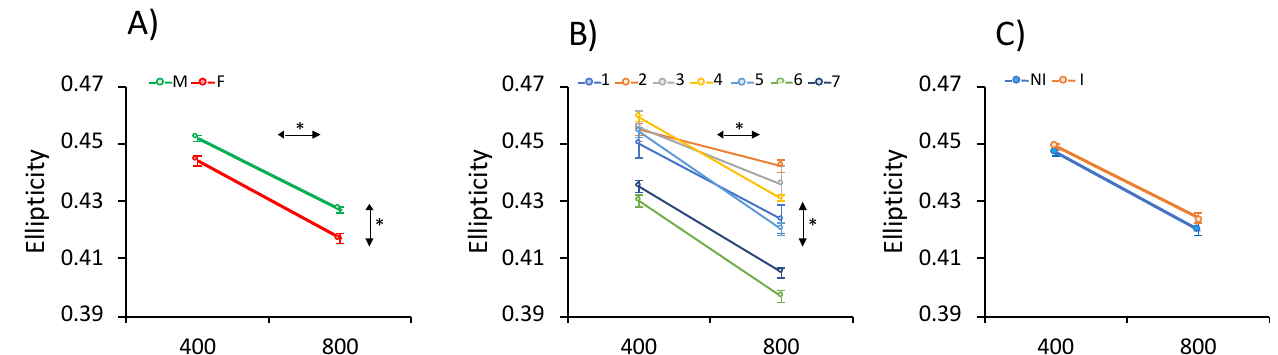
Figure 6. Estimated marginal means for ellipticity as determined by repeated-measures ANOVA at 400 and 800 days (d) for the ( A ) gender (male: M; female: F), ( B ) Evaluation Batch (EB) (1–7) and ( C ) Amoebic disease (AD) (infected: I; non-infected: NI). The asterisks (*) on the horizontal or vertical arrows denote if within- or between-subject effects were signif- icant.